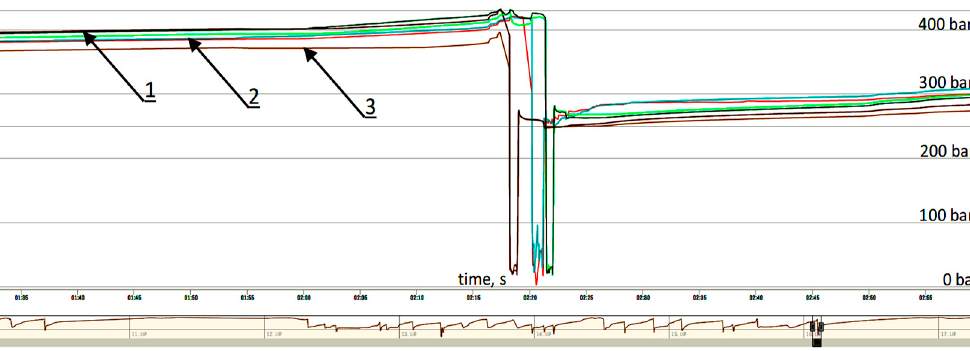
Figure 5. Measurement of the pressure difference in the legs of the powered support during its operation: 1, powered support in longwall no. 43; 2, powered support in longwall no. 44; 3, pow- ered support in longwall no. 45.